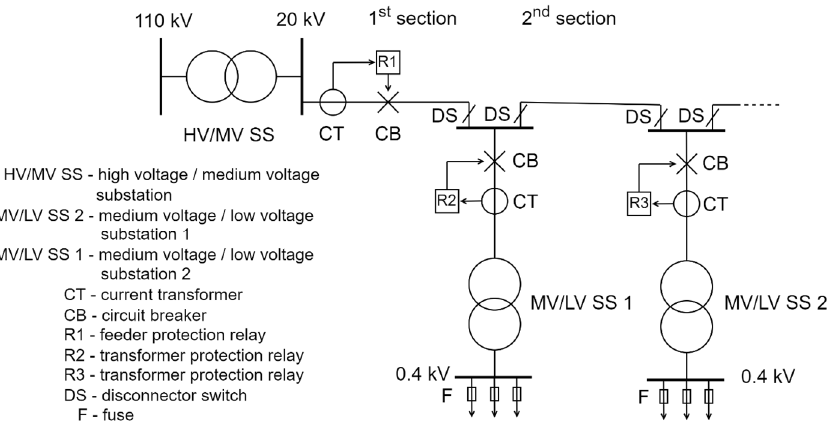
Figure 1. Combined use of definite-time and inverse-time overcurrent relays (OCRs). Consumers can be connected on a low voltage (LV) network or directly on a medium voltage (MV) network, meaning that in the latter case the MV/LV transformer and the downstream network is a customer’s ownership and maintenance responsibility. However, in both cases the protection philosophy is similar: the feeder’s first line section contains the protection elements (relay denoted as R1 and circuit breaker), which cover all subsequent lines of that feeder. This means that if the short circuit (of any type) occurs, for example on the last line of the feeder, the CT located in the beginning of the first section must detect